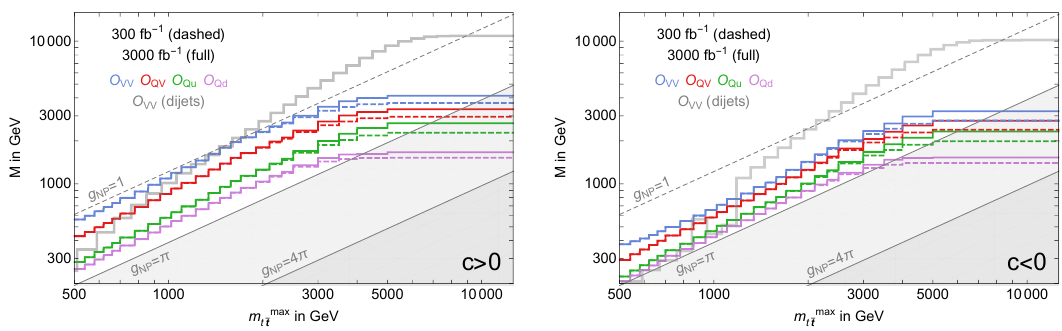
Figure 4 . Projected 95% CL bounds on four fermion operator mass scales. We show the de- pendence of the bounds on the t (cid:22) t invariant mass cut m max . On the left the bounds are shown t (cid:22) t for the case of positive operator coe(cid:14)cients, corresponding to constructive interference with the SM amplitude, while on right we show the case of negative operator coe(cid:14)cients and destructive interference. We show the estimated region of validity of the EFT description (above the straight lines) for various assumptions about the coupling strength in the short distance model generating the e(cid:11)ective